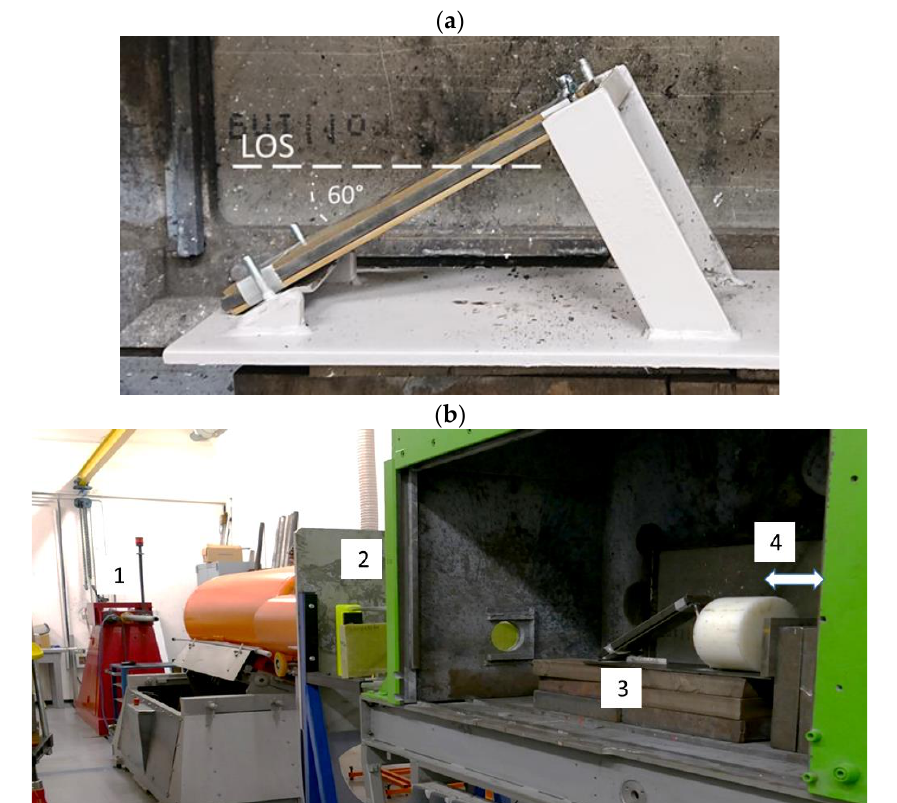
Figure 3. ( a ) NERA armour inclined at 60° NATO angle. ( b ) Experimental stand (explanations in the text).